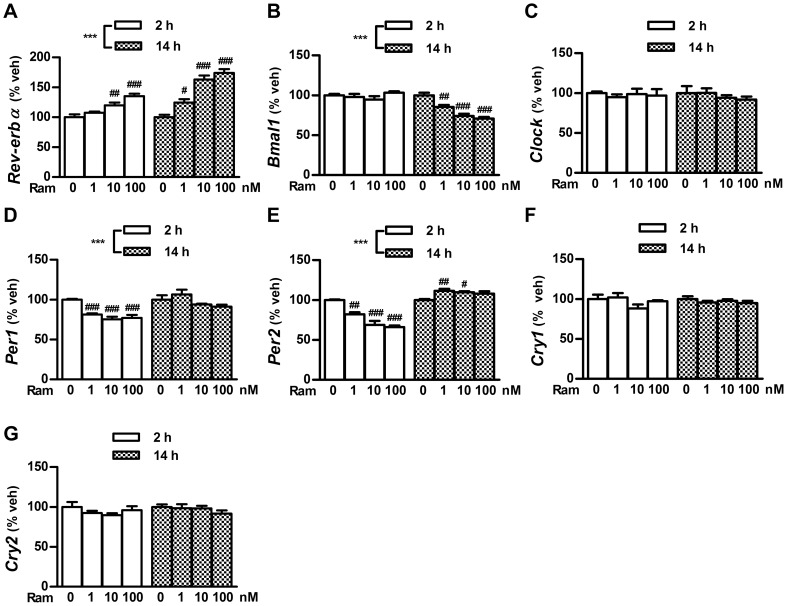
Concentration-dependent changes in ramelteon-induced clock gene expression.INS-1 cells were treated with ramelteon (1, 10, or 100 nM) for 2 or 14 h. mRNA expression of Rev-erbα (A), Bmal1 (B), Clock (C), Per1 (D), Per2 (E), Cry1 (F), and Cry2 (G) was assessed using TaqMan polymerase chain reaction and normalized to that of the housekeeping gene cyclophilin A. Values are expressed as a percentage of the vehicle-treated control. Data are presented as means ± SEM (n = 4) and were analyzed using 2-way analysis of variance followed by Dunnett's test. ***P<0.001, 2 h treatment vs. 14 h treatment; #
P<0.05, ##
P<0.01, ###
P<0.001 vs. vehicle-treated control.